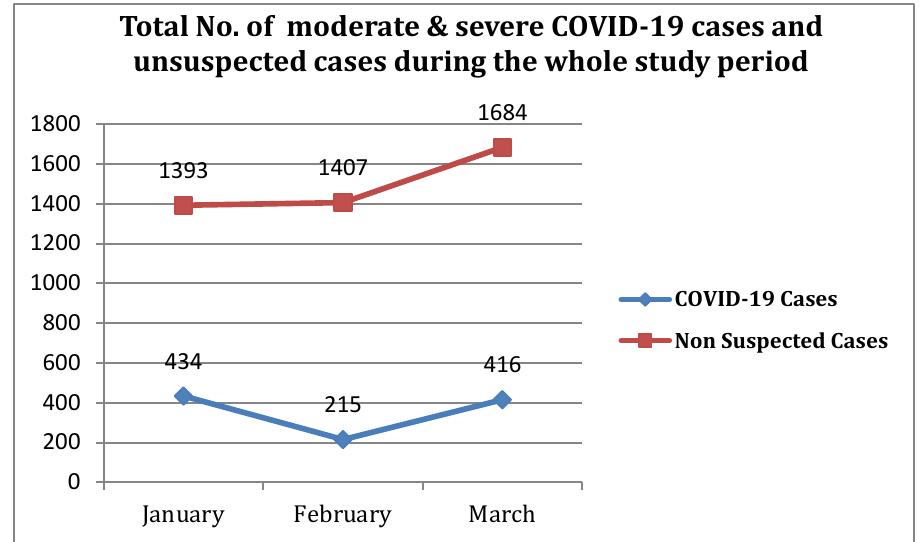
Figure 4. Total No. of moderate & severe COVID-19 cases and unsuspected cases at ZUH during the whole study